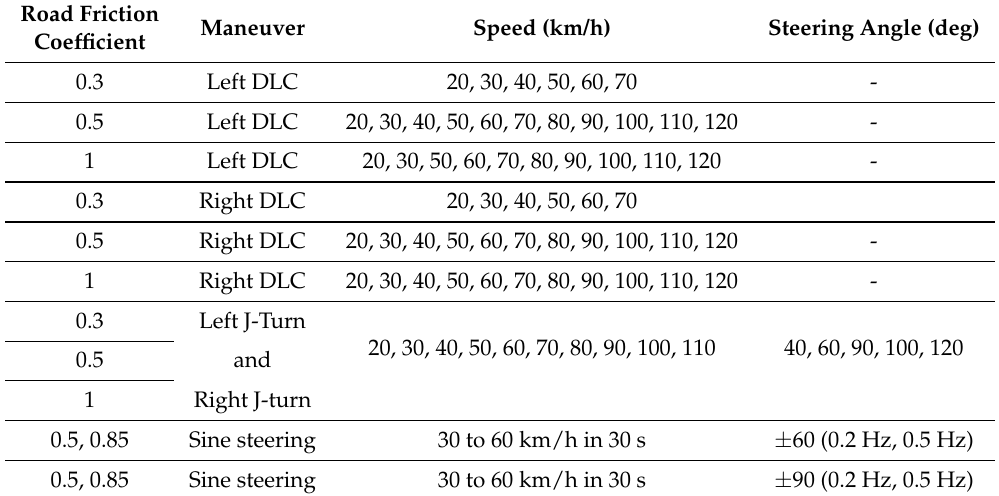
Table 1. Training DNN data sets (Trucksim R (cid:13)